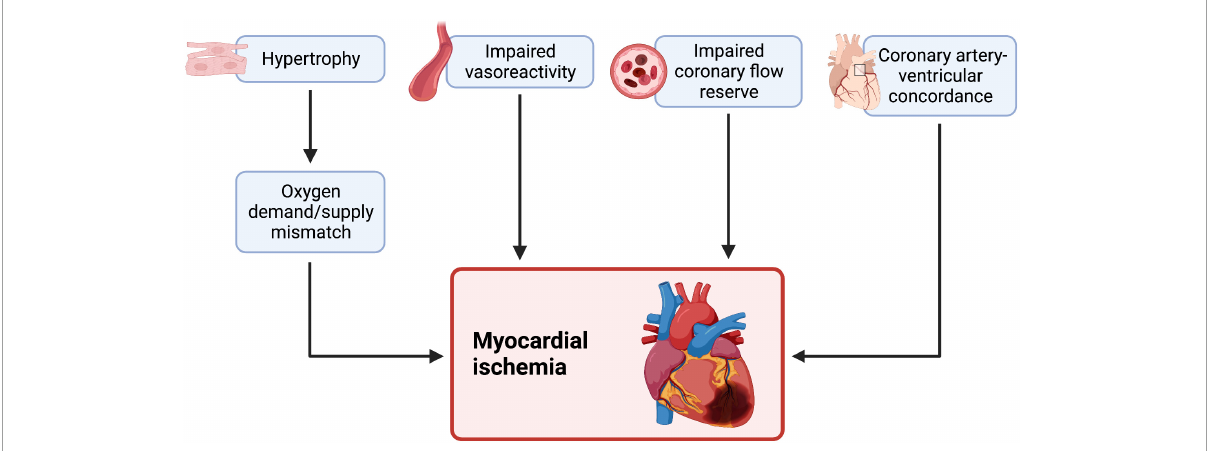
FIGURE3 Myocardial ischemia and an impaired coronary flow reserve is independently associated with cardiac dysfunction and heart failure in systemic LV and sRV failure. sRV patients also show impaired vascular reactivity to adenosine (a vasodilator) during stress. A hypertrophied sRV may effectively outgrow its blood supply, creating an oxygen demand and supply mismatch and consequent ischemia. The RV is usually supplied throughout all phases of the cardiac cycle, but this may change in sRV, as some reports hypothesize that sRV perfusion is diastole-dependent, causing ischemia. Therefore, myocardial ischemia in sRV may be ischemia in sRV may be explained by various mechanisms, some of which may be amenable to treatment. We created the figure with